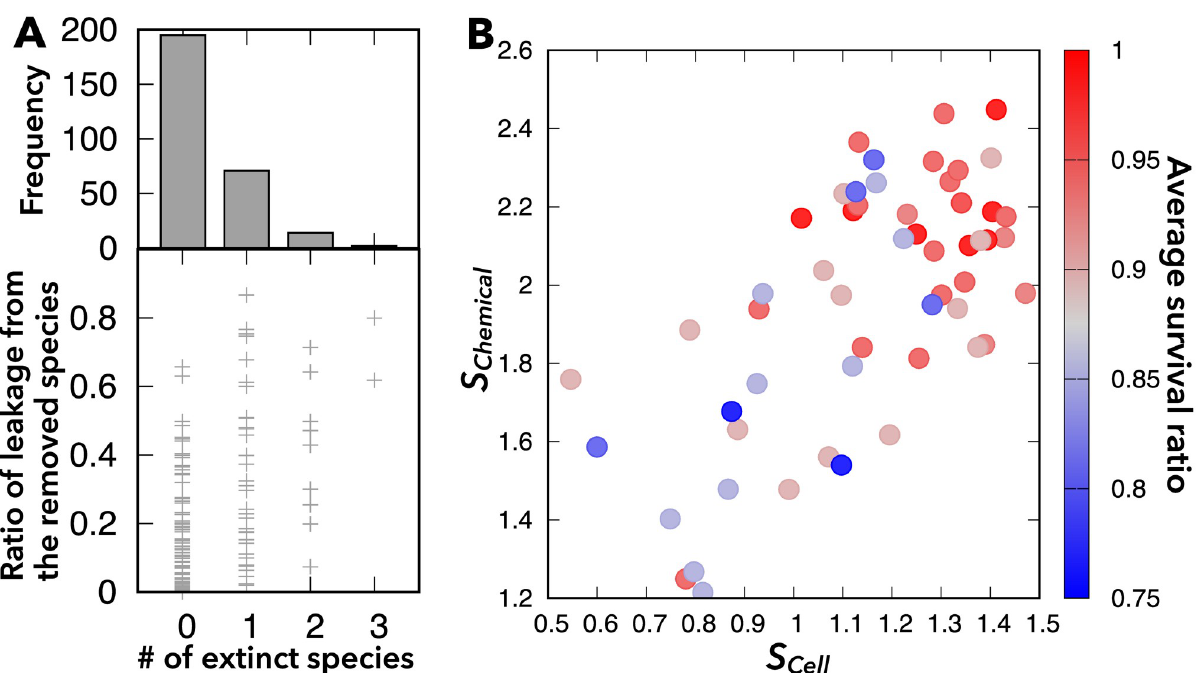
Fig 5. Resilience of symbiotic coexistence against the removal of one species. (A) The upper panel shows the frequency distribution of the number of cell species (0–3) that become extinct when one species is removed. The lower panel shows the ratio of leakage of chemicals from the removed cell species to the total leakage from all cell species to the environment, P Leak, α . Each point corresponds to a sample shown in the upper panel. (B) Average survival ratio (color) against the indices that characterize the diversity of leaking cell species ( S Cell ) and leaked chemical components ( S Chem ). The survival ratio is the number of surviving species after removal of one species, divided by the number of species before the extinction successive to the removal. (If no additional cell species become extinct, this ratio equals one.) The multiple correlation coefficient between survival ratio and ( S Cell , S Chem ) is 0.49, while the correlation coefficients between the survival ratio and S Cell , between the survival ratio and S Chem , and between S Cell and S Chem are 0.46, 0.43, and 0.65, respectively. For these calculations, we used 55 samples of coexistence of five or six species with n = 20.